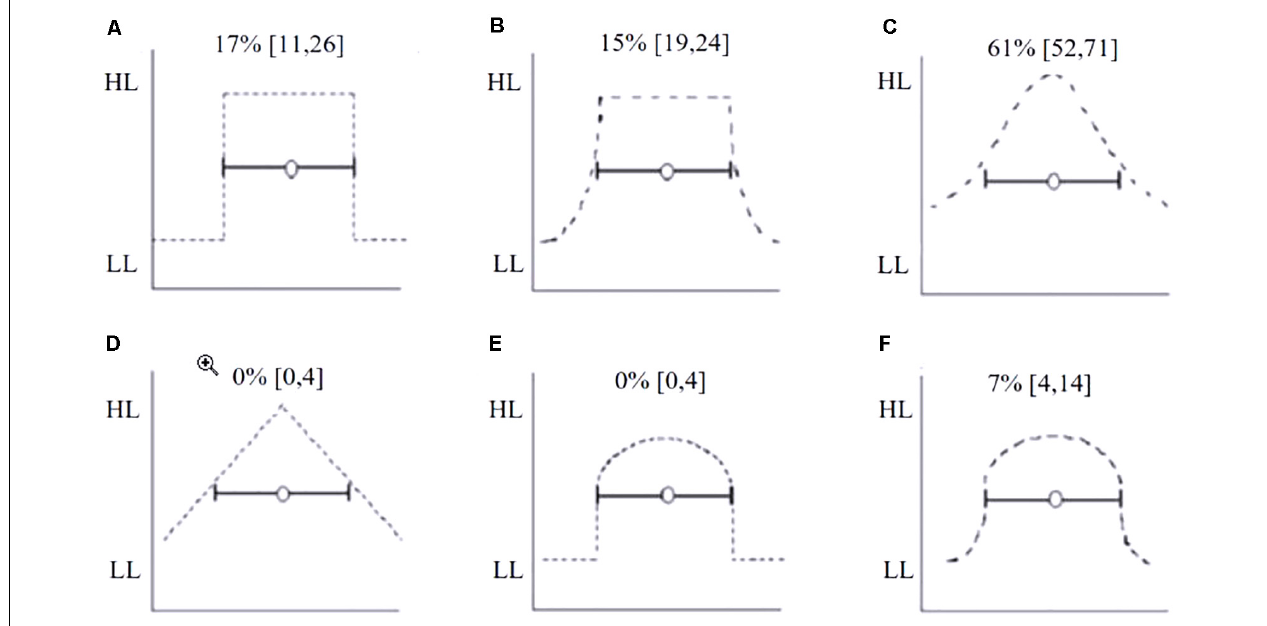
FIGURE 6 | Six likelihood distributions presented as response options for Task 3. (A) Square, (B) Mesa, (C) Bell curve, (D) Triangle, (E) Half Circle with no change in likelihood after the lower limit, (F) Half Circle with a gradual change in likelihood after the lower limit. Students selected which distribution best matched their own SLD of a 95% CI. The percentage of students selecting each option is shown directly above the distribution. The Y -axis represents likelihood ranging from high likelihood (HL) to low likelihood (LL).